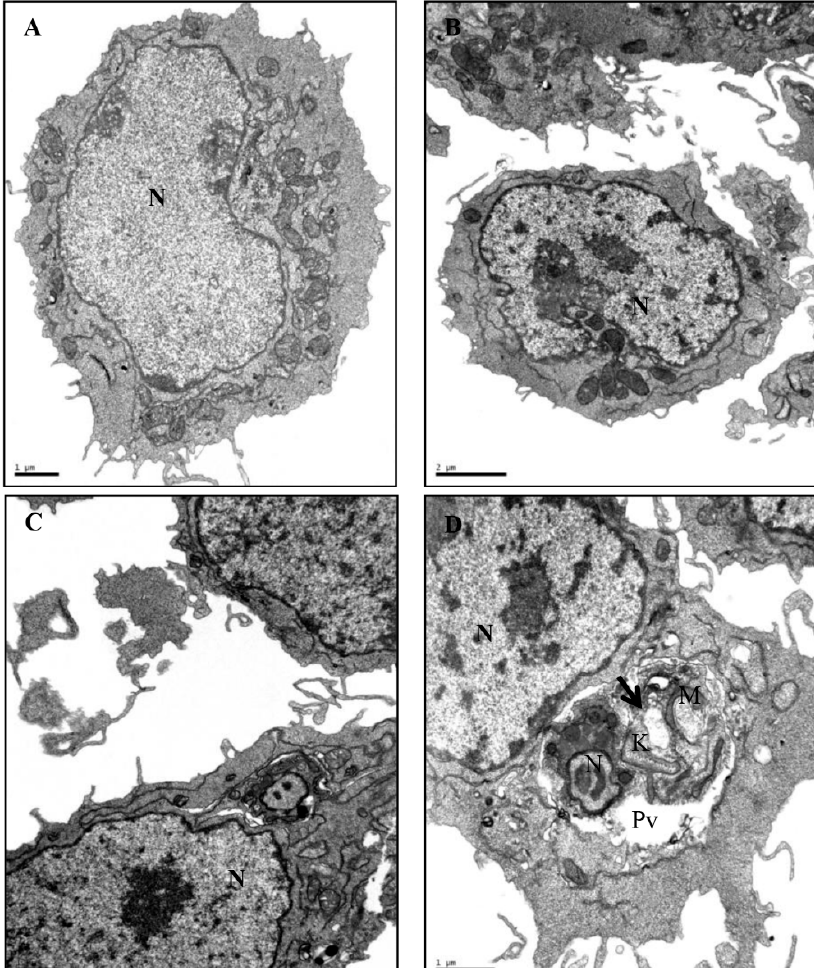
Figure 5. Ultrastructural effects of Endlicheria bracteolata essential oil on intracellular Leishmania amazonensis amastigotes and macrophage cells. ( A ) Untreated and uninfected macrophages showing typical morphology; ( B ) macrophages treated for 24h also showing typical morphology; ( C ) infected macrophages showing intact kinetoplast in the amastigote forms; ( D ) Infected and treated macrophages showing ultrastructural changes in the amastigotes such as the presence of vacuoles (arrows) in the cytoplasm and damage to their mitochondria (M). No changes were observed in the morphology of the host cell. N: nucleus ; M: mitochondria ; K: kinetoplast ; Pv: parasitophorous vacuole .